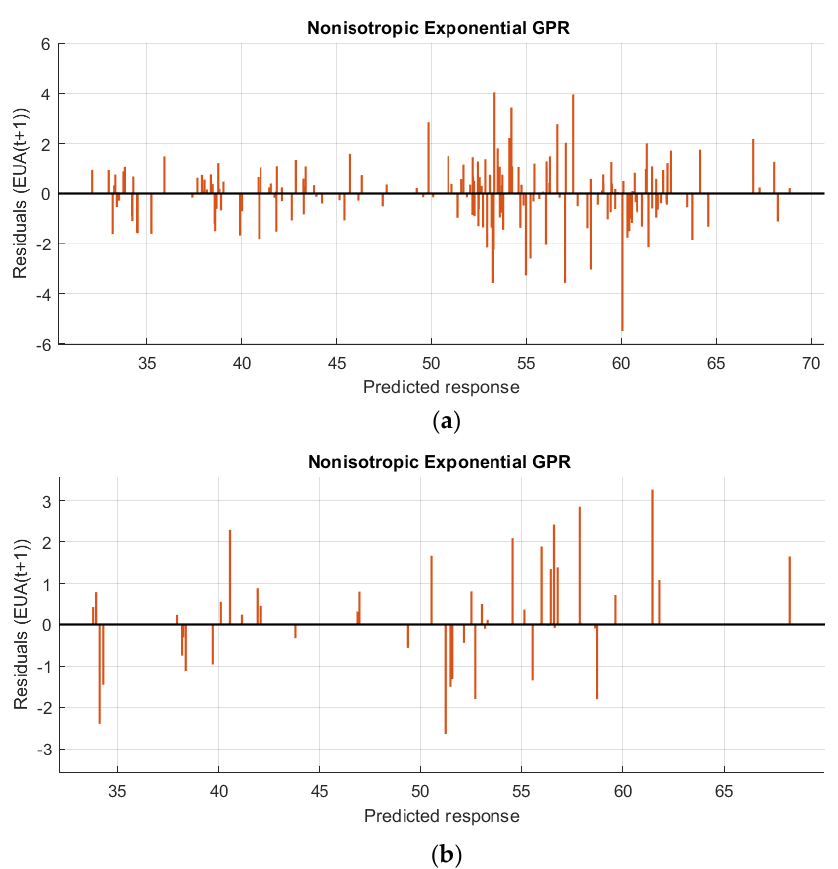
Figure 14. Dependence between residuals and predicted responses, using Non-isotropic Exponential GPR for ( a ) train data, ( b ) test data.